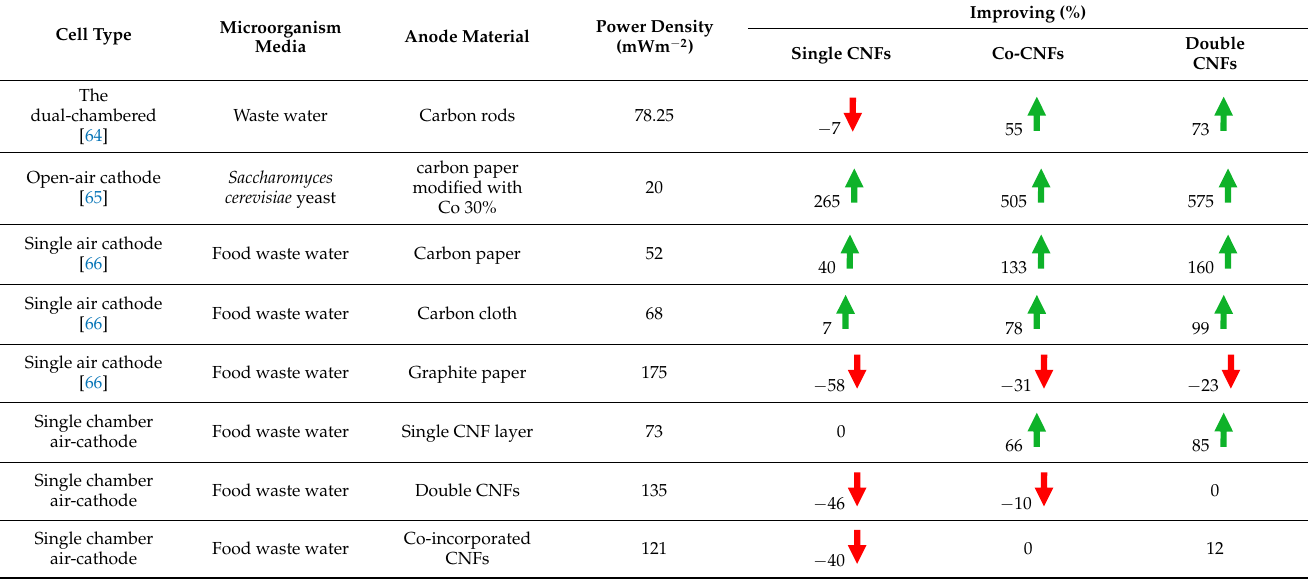
Figure 10. Columbic efficiency (CE) and COD of the final solution after 24 h batching of MFCs using different anodes.